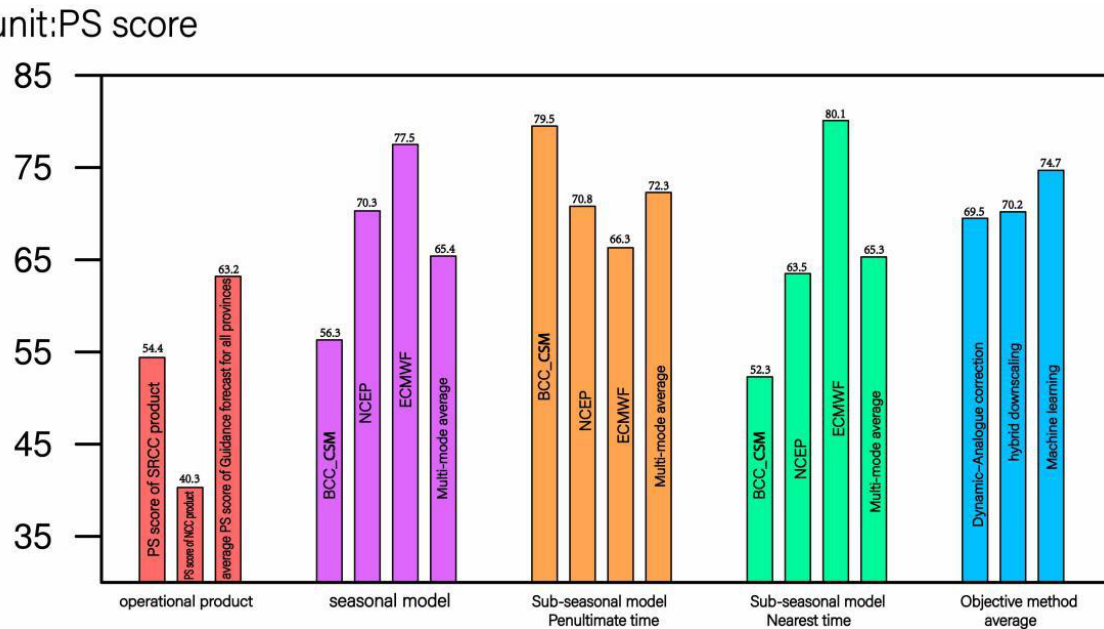
Figure 4. PS scores of July precipitation forecasts from different schemes.